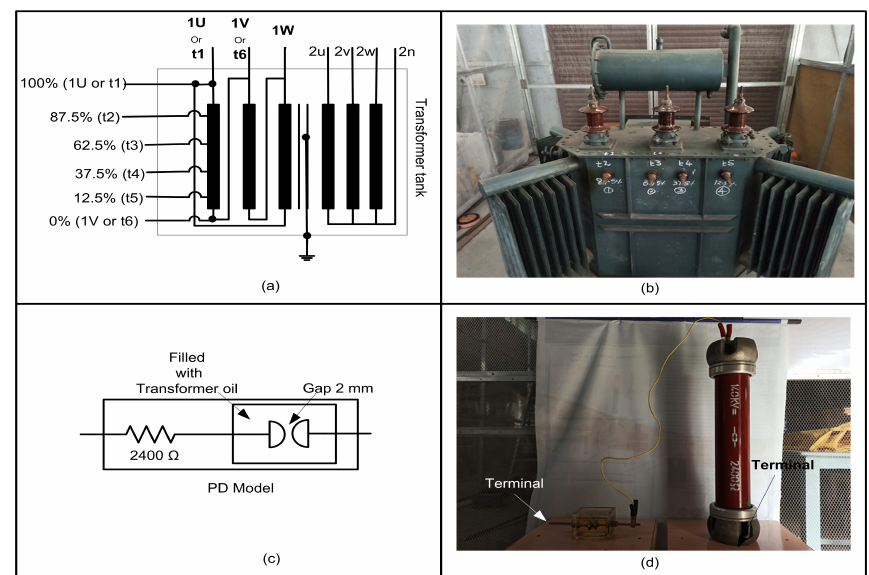
Figure 1. ( a ) Circuit representation of the Transformer. ( b ) Photograph of the transformer ( c ) Circuit representation of the Partial Discharge (PD) model. ( d ) Photograph of the PD model.